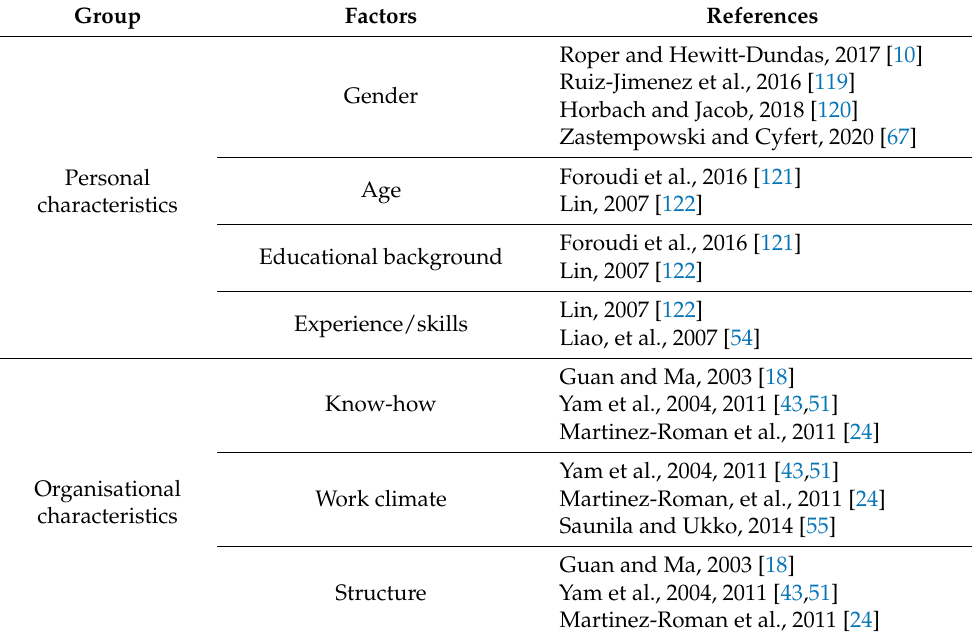
Table 2. Micro-enterprise innovation capability